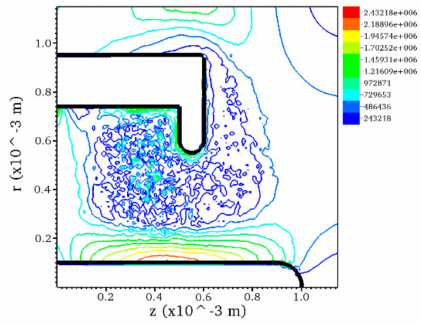
Figure 9. Contour plot of the electric field (V / m) (400 A, 100 V, 4 g /